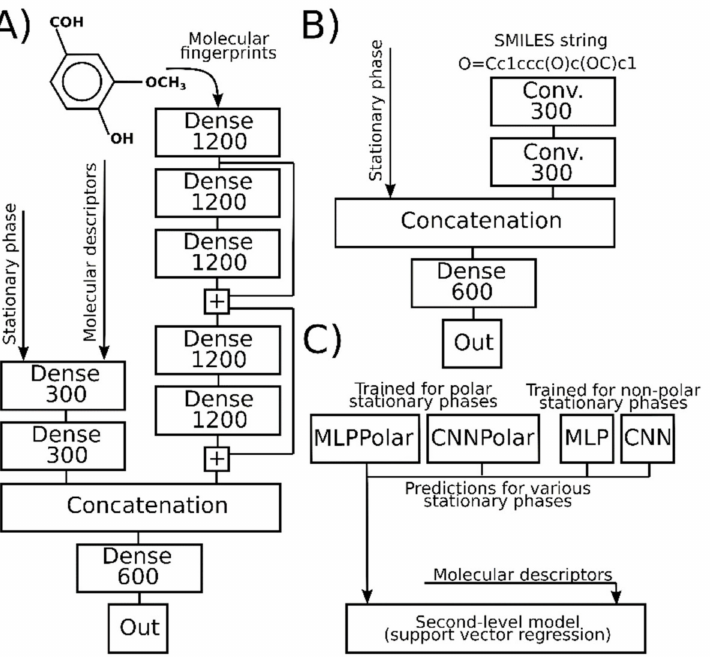
Figure 1. The machine learning models that were used in this work. Dense—a fully connected layer. Conv.—a convolutional layer. “+” indicates element-wise additions. The number in the block denoting the layer indicates the number of output nodes/channels. ( A )—the depiction of MLP and MLPPolar models. ( B )—the depiction of CNN and CNNPolar models. ( C )—the second-level support vector regression